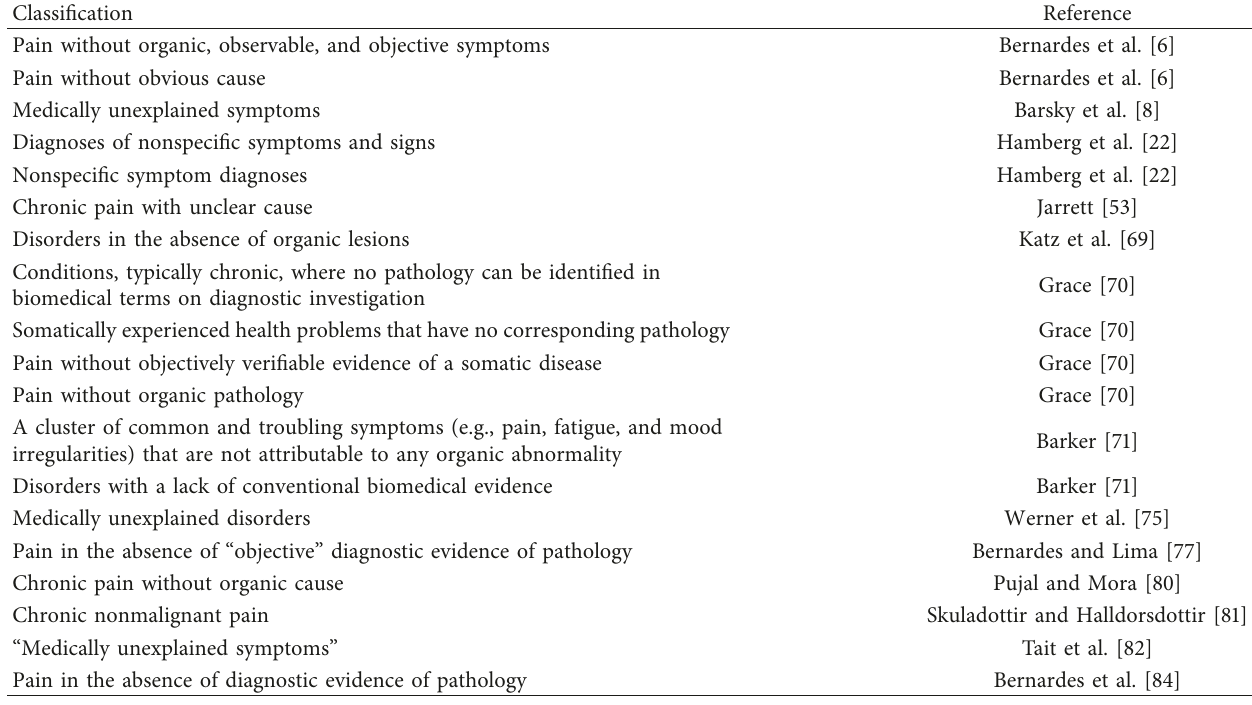
Table 3: Medically inexplicable pain conditions. List of classification terms and references among 77 articles reviewed.